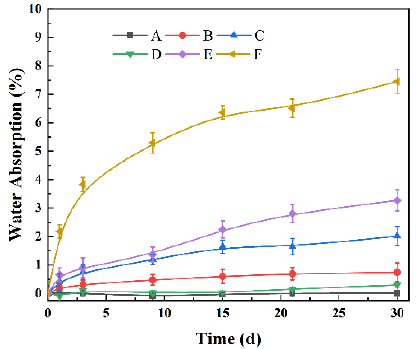
Figure 7. Water absorption of the